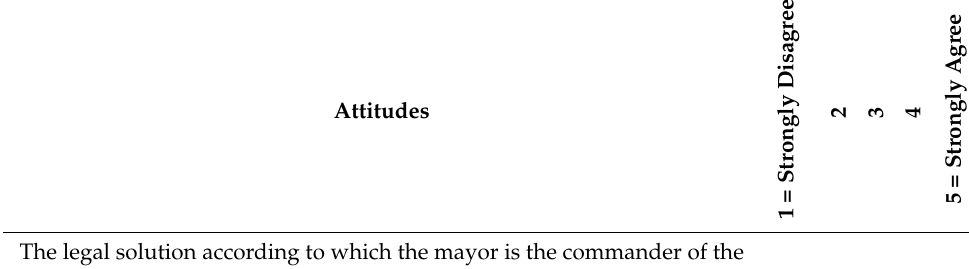
Table A1. Attitudes of heads (mayors) of disaster sectors in local self-government units.